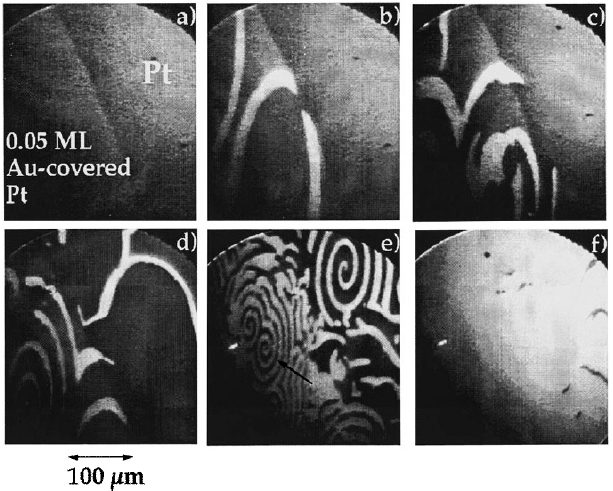
Figure 7. Study of different reactive behaviours in the presence and absence of Au: PEEM snapshots during the CO oxidation on 0.05 ML Au-covered Pt(110) adjacent to a bare Pt(110) area. Conditions of acquisition: T = 460 K, P O = 4 × 10 − 2 Pa. The pressure is increased from ( a ) P CO = 1.0 × 10 − 3 Pa: two regions in the O-covered stable states; ( b ) P CO = 1.7 × 10 − 3 Pa: formation of CO(ads) domains on the Au-covered side; ( c ) P CO = 1.9 × 10 − 3 Pa: formation of CO fronts nucleating by diffusion across the boundary; ( d ) P CO = 3.0 × 10 − 3 Pa: formation of spirals on the Au-covered domain and formation of fronts on the Pt domain; ( e ) P CO = 4.65 × 10 − 3 Pa: spiral patterns on both domains; ( f ) P CO = 5.0 × 10 − 3 Pa: Au-covered domain fully covered by CO(ads) and presence of O(ads) waves on the Pt domain. Reprinted from [179], Copyright 1995, AIP Publishing.